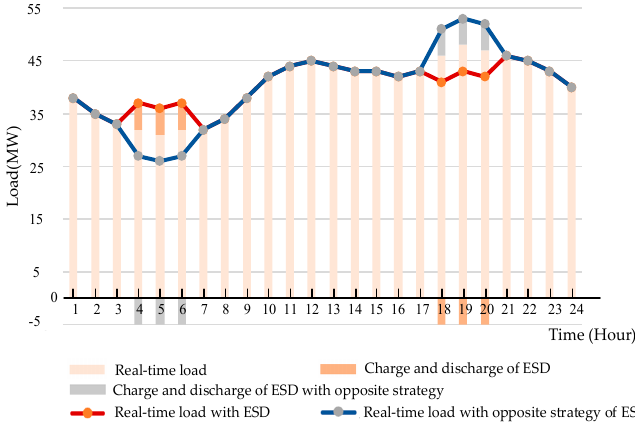
Figure 6. Comparison of load profile in Scheme 4.3 with the original scheme.